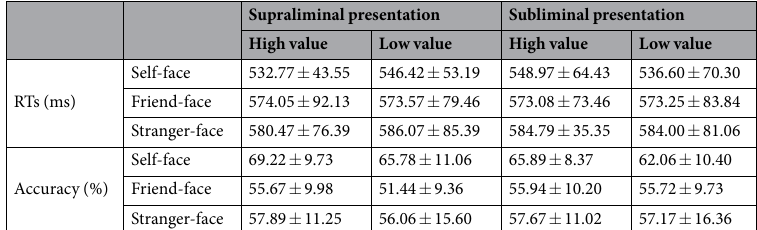
Table 1. Mean reaction time and accuracy for faces in the reward conditions ( M ± SD ).